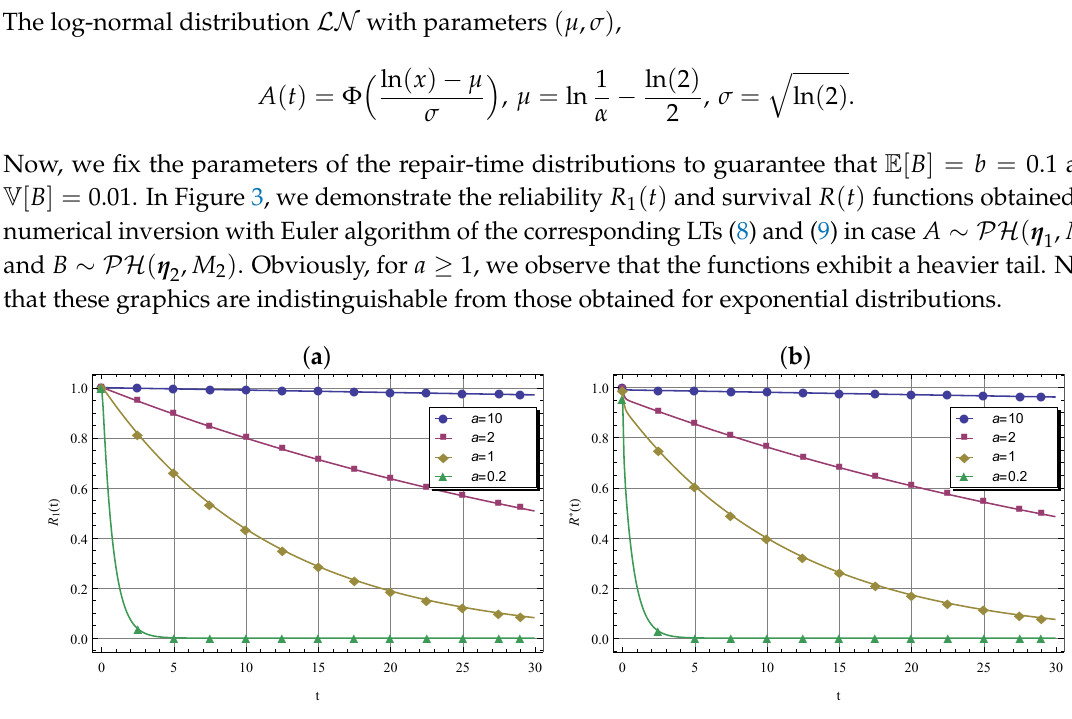
Figure 3. Functions R 1 ( t ) ( a ) and R ( t ) ( b ) for A ∼ PH ( η